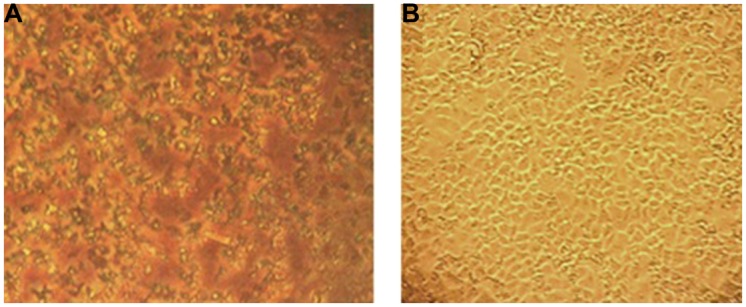
Effect of EGCG on MA-104 cell cultures. (A) Three hundred microgram EGCG induces a precipitation effect in microtitier wells containing MA-104 cell cultures maintaned in minimal essential medium plus supplements. (B) Untreated MA-104 monolayer culture. Amino acids and proteins are known to bond onto EGCG in a stacking pattern to which the above effect may be ascribed in (see text for details).